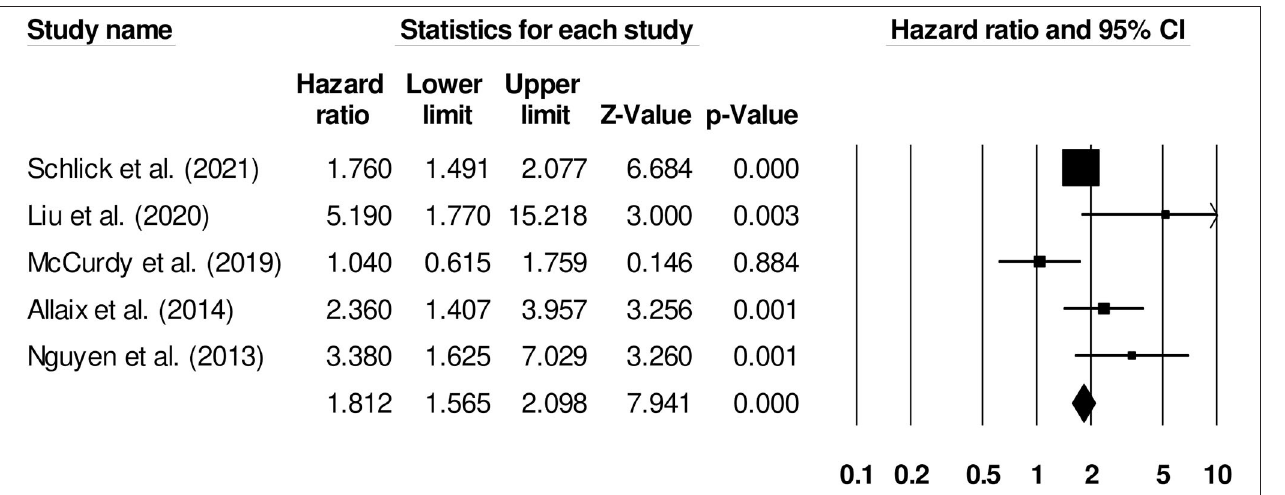
FIGURE 8 | Forest plot for studies evaluating the effect of ulcerative colitis on the risk of venous thromboembolism in patients with inflammatory bowel disease. The hazard ratios are presented as black boxes whereas 95% confidence intervals are presented as whiskers. A small hazard ratio represents lower risks of venous thromboembolism in ulcerative colitis patients with inflammatory bowel disease, a higher hazard ratio represents higher risks of venous thromboembolism in ulcerative colitis patients with inflammatory bowel